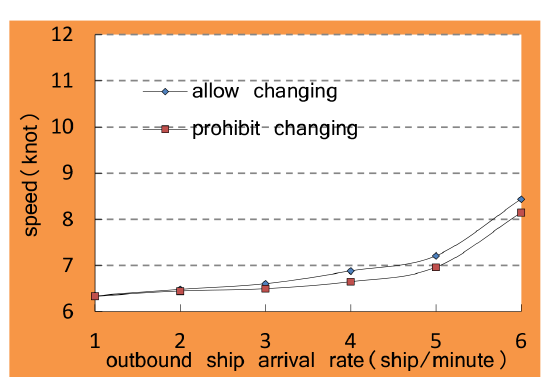
Figure 21. Average speed of waterway system and ship arrival rate as a function (inbound ship arrival rate = 2)